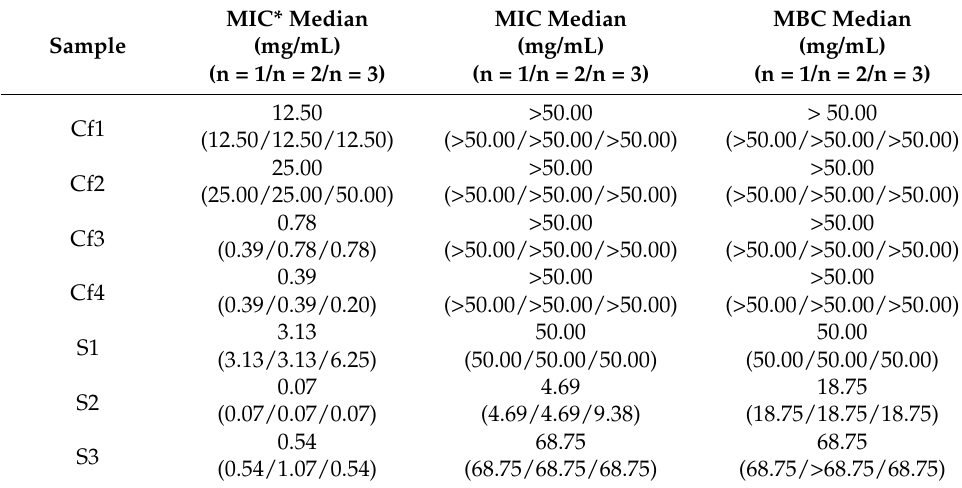
Table 4. Antibacterial activity of codfish and sardine extracts against K. pneumoniae .